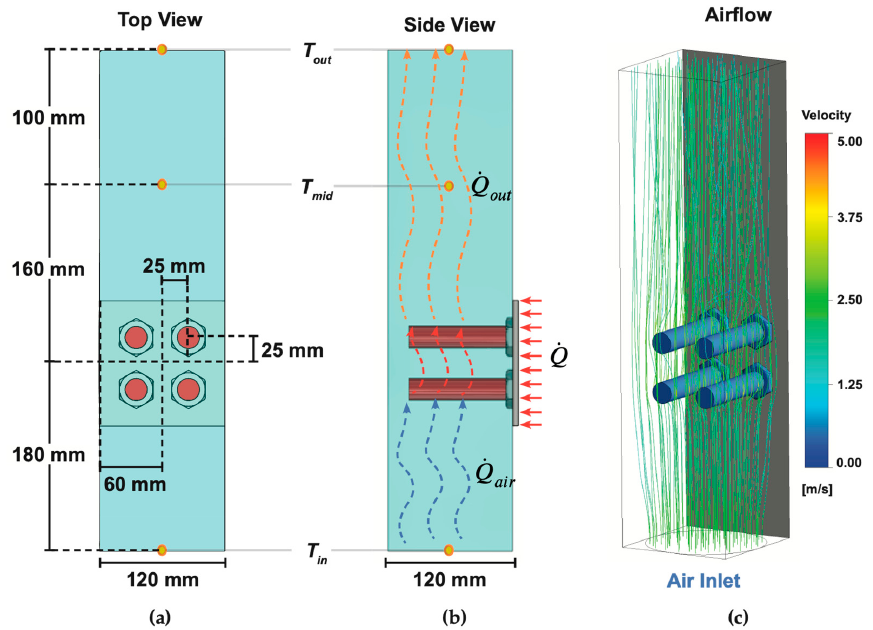
Figure 2. The simulation setup: ( a ) Top view; ( b ) Side view; ( c ) Airflow.